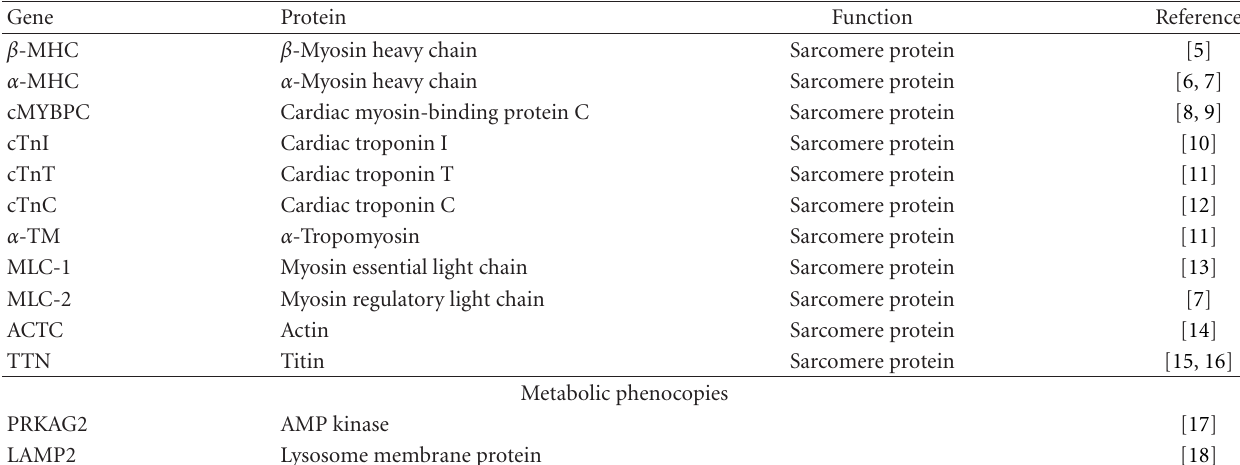
Table 2: Genes associated with hypertrophic